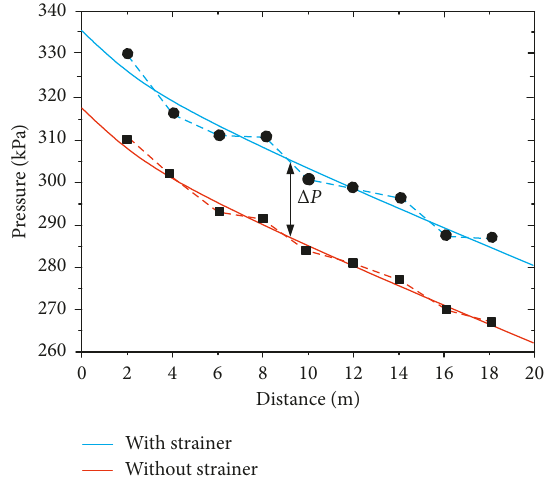
Figure 5: Effects of the strainer in the pressure transmitter on the gas-phase pressure drop.